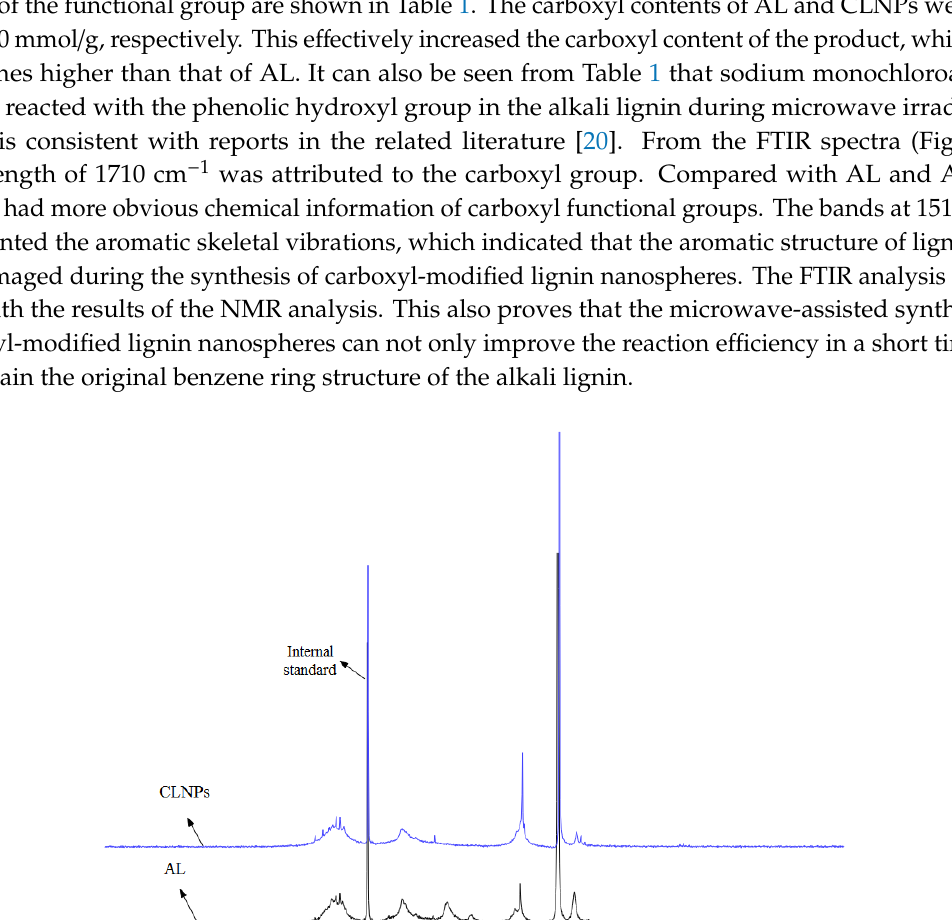
Table 1. The contents of functional groups in AL and CLNPs.